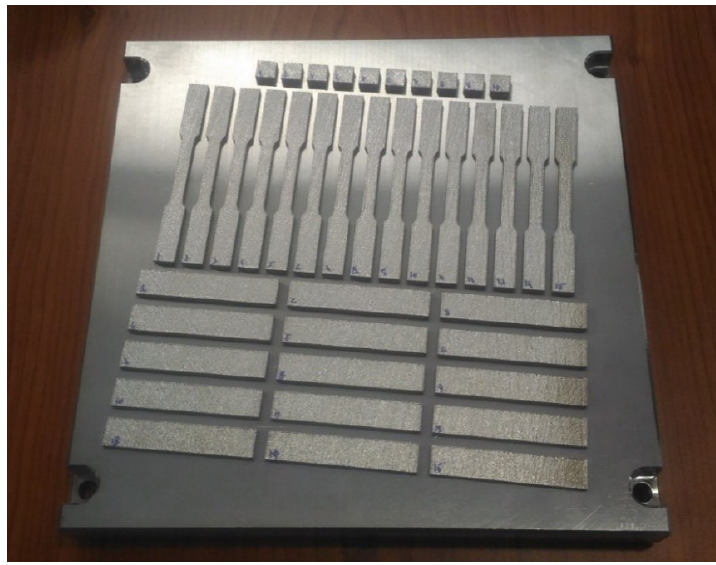
Figure 1. Positions of the specimens on the SLM